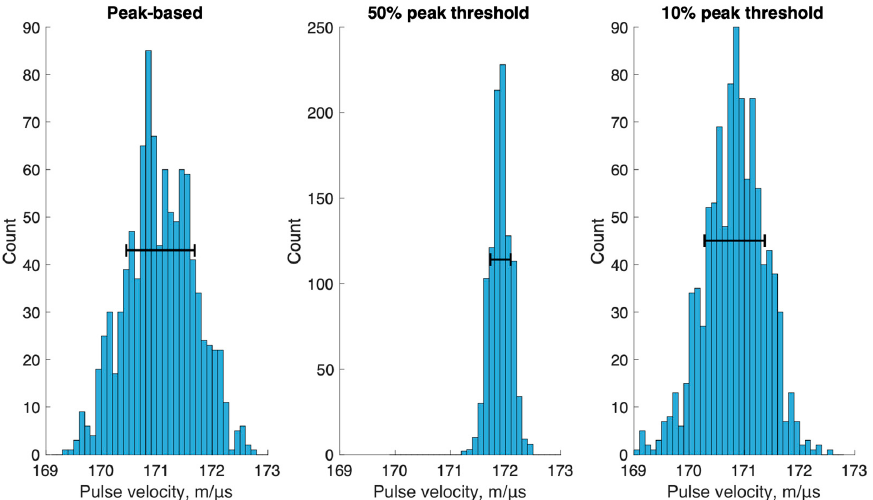
Figure 9. Pulse velocity histograms for 1 nC pulses (1000 total) injected near the cable’s end, including SD around the mean, measured using the IEC 60270-compliant system.